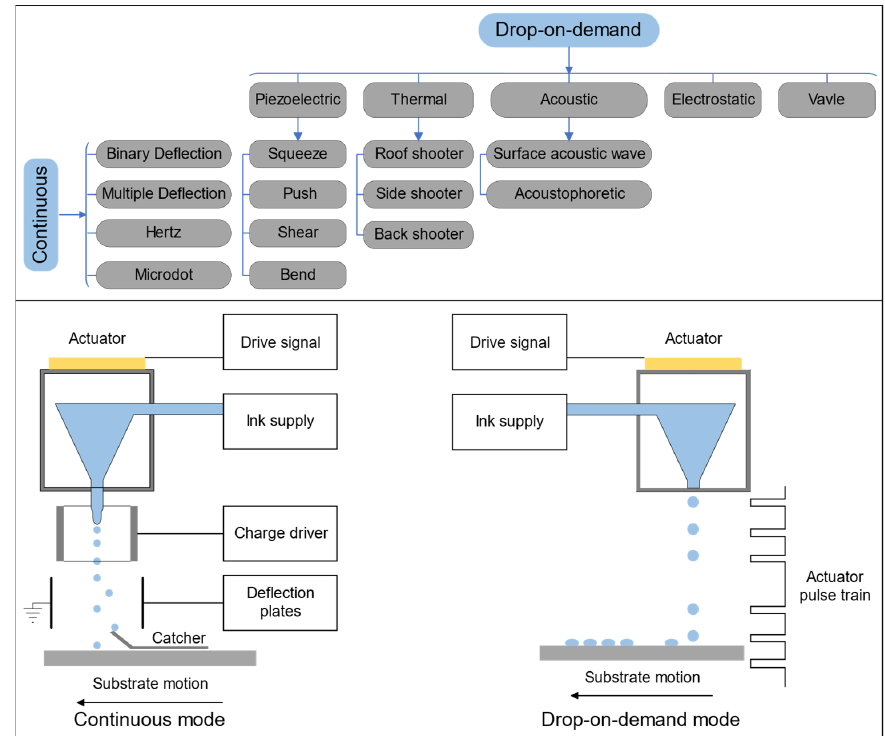
Figure 3. The classification of IJP [59].